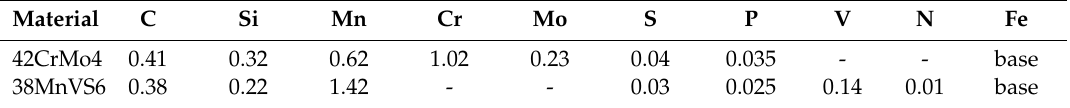
Table 1. Chemical composition of 42CrMo and 38MnVS6 (wt. %).